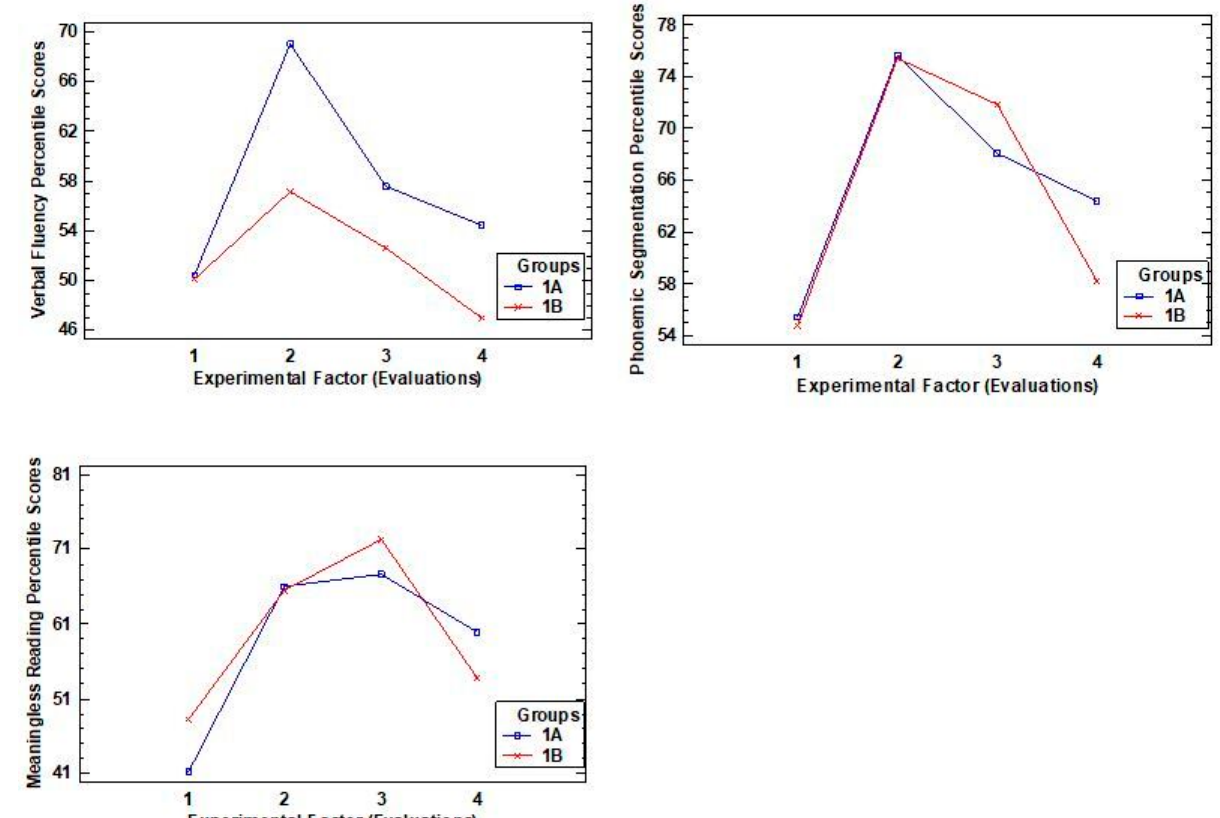
Figure 2. Graphs showing the interaction of the variables: verbal fluency and phonemic segmentation (phonological awareness), reading without meaning (decoding).